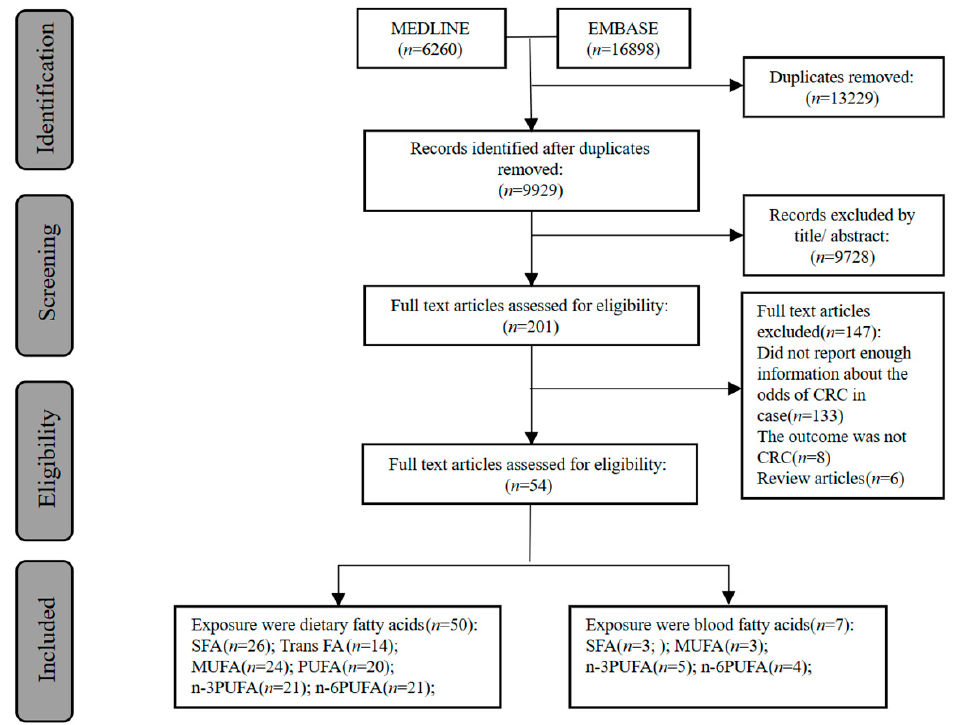
Figure 1. Flow diagram of observational and Mendelian randomization studies selection.